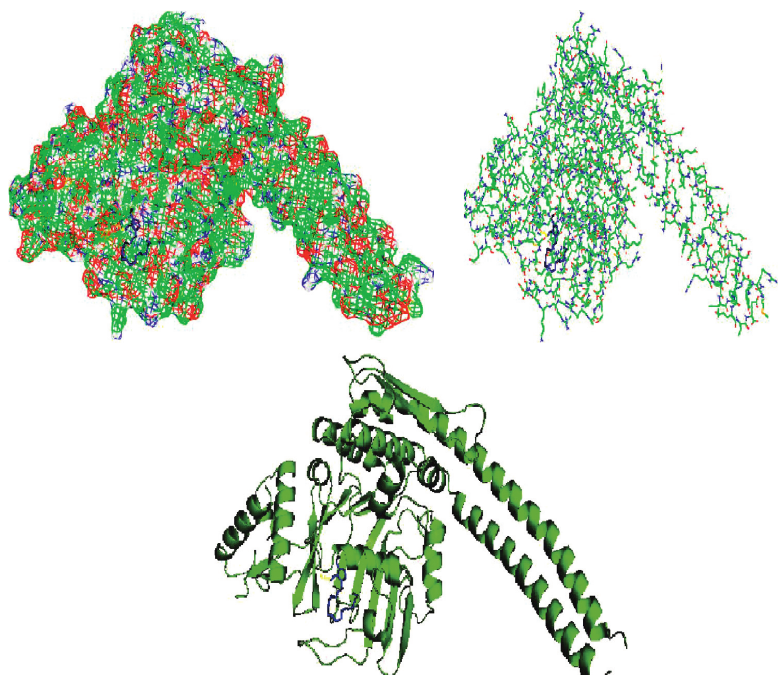
Figure 7: Three-dimensional plot of interaction of triazole ligand with B. subtilis (5 h67) receptor.